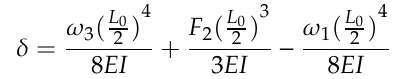
Figure 6. Capillary transport of miniature elastic ribbon. ( a ) a needle is above a ribbon; ( b ) the ribbon is picked up by the needle; ( c ) the ribbon is transported to the target location; ( d ) water mist is introduced; ( e ) the ribbon is released on the target site; ( f ) water droplets evaporate. The images are snapshots from the Supplementary Video S1.